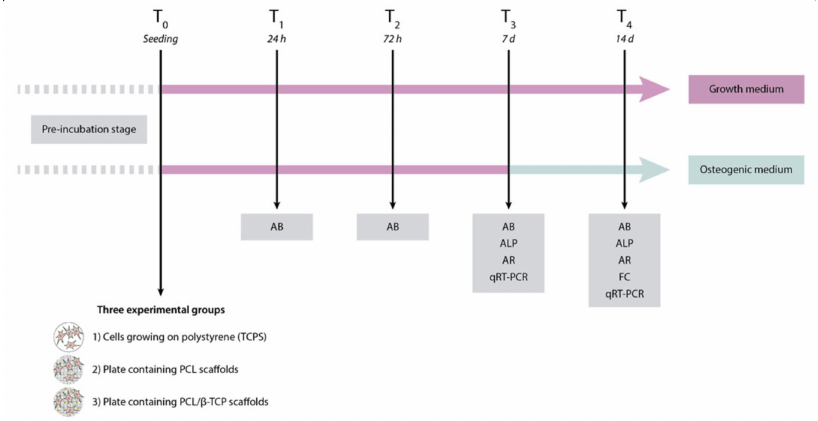
Figure 1. Schematic representation of the study design, including the time schedule of the performed experiments. AB, AlamarBlue assay; ALP, alkaline phosphatase; AR, alizarin red staining; FC, flow cytometry; qRT-PCR, quantitative polymerase chain